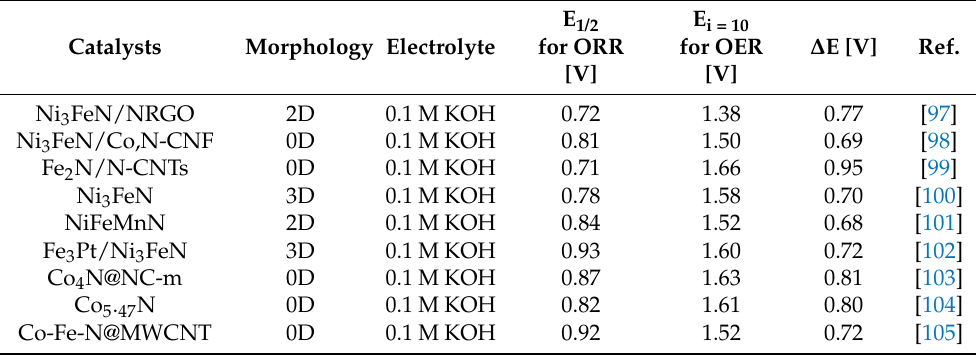
Table 2. Summary of the OER&ORR activities of recently reported electrocatalysts based on TMNs (the voltage gap: ∆ E = E j = 10 − E 1/2 ).